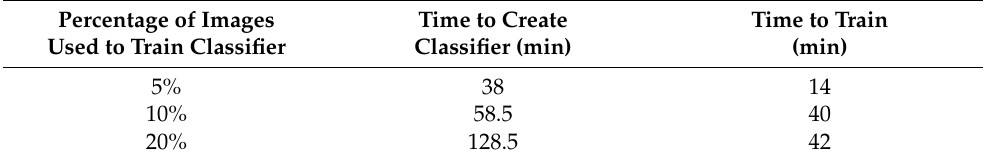
Table 1. Time taken to create and train the